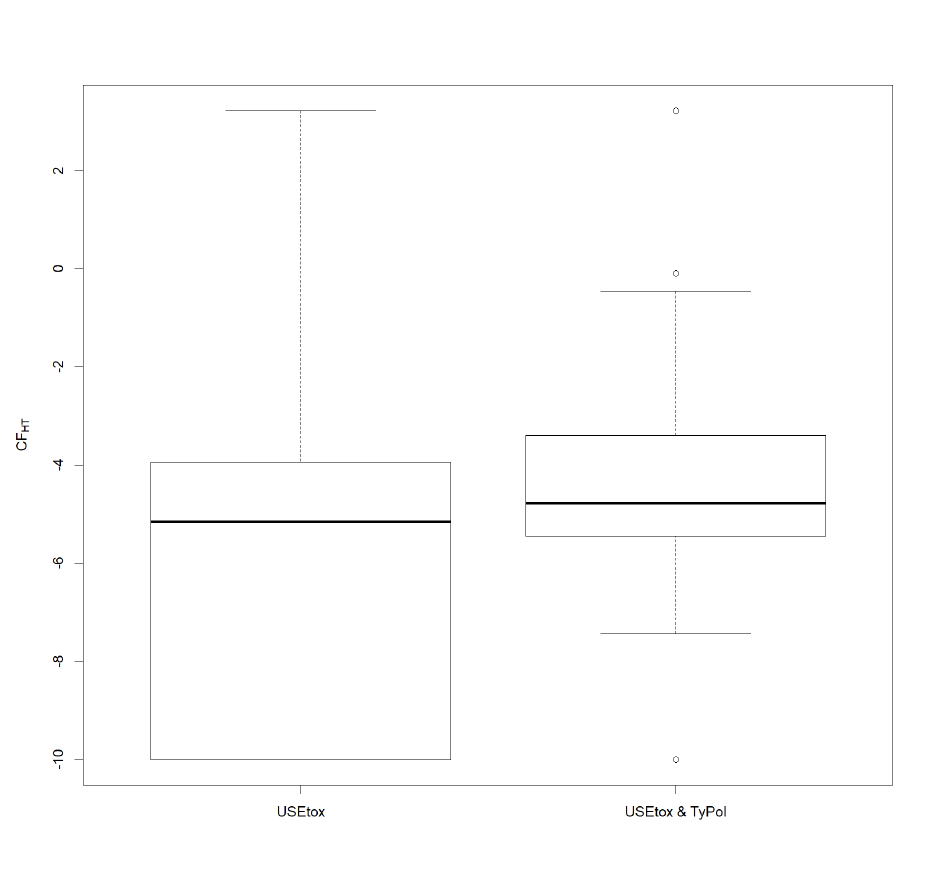
Figure 2 Boxplots of the CF HT for the USEtox® database and the common molecules between the USEtox® and the TyPol databases. This CF HT is equal to log 10 ((DALY+ε).kg -1 ). The ε is needed as some values of the DALY are exactly equal to zero. ε has been chosen equal to 1e-10 to be below the minimum of the USEtox® database